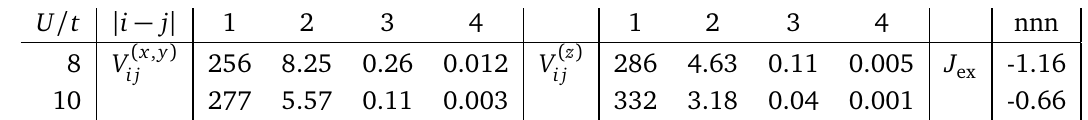
Table 2: Values for the HS-HS interaction amplitudes in meV units in the effective model (5) at two different amplitudes of U / t